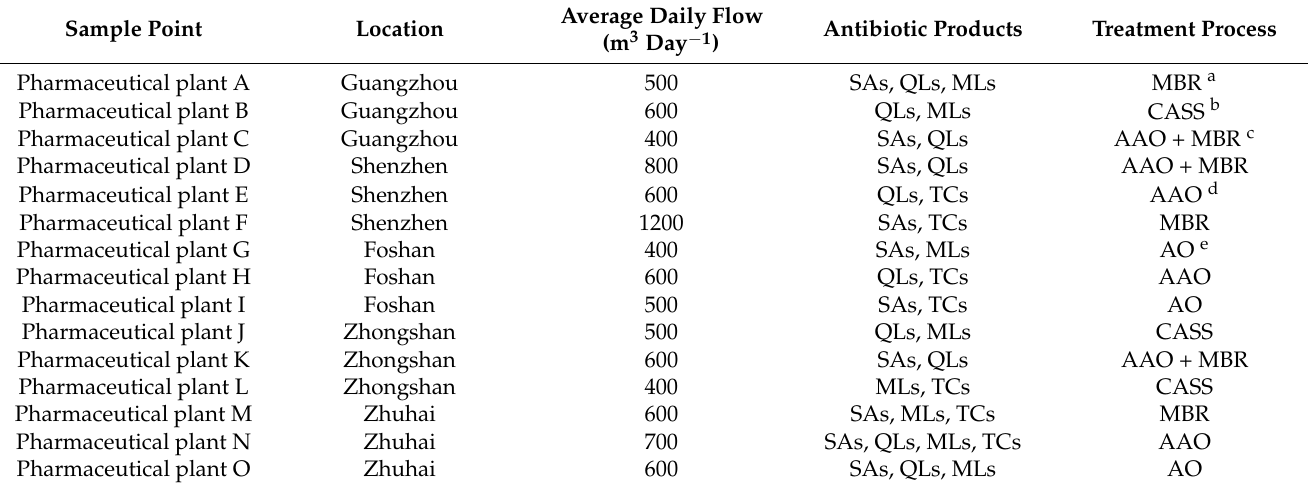
Table 1. The specific coordinates of each sampling